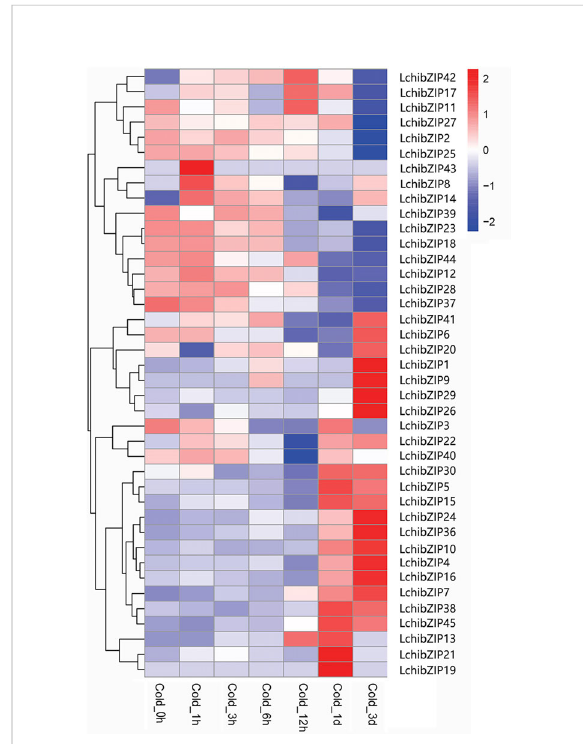
FIGURE 10 Expression pro fi les of LchibZIP genes. The RNA-sequence data was obtained from leaf of L. chinense.